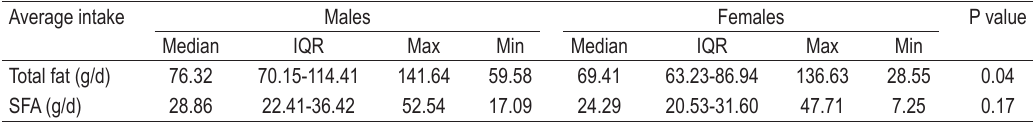
TABLE 3. Average intakes of total fat and saturated fatty acids Average intake